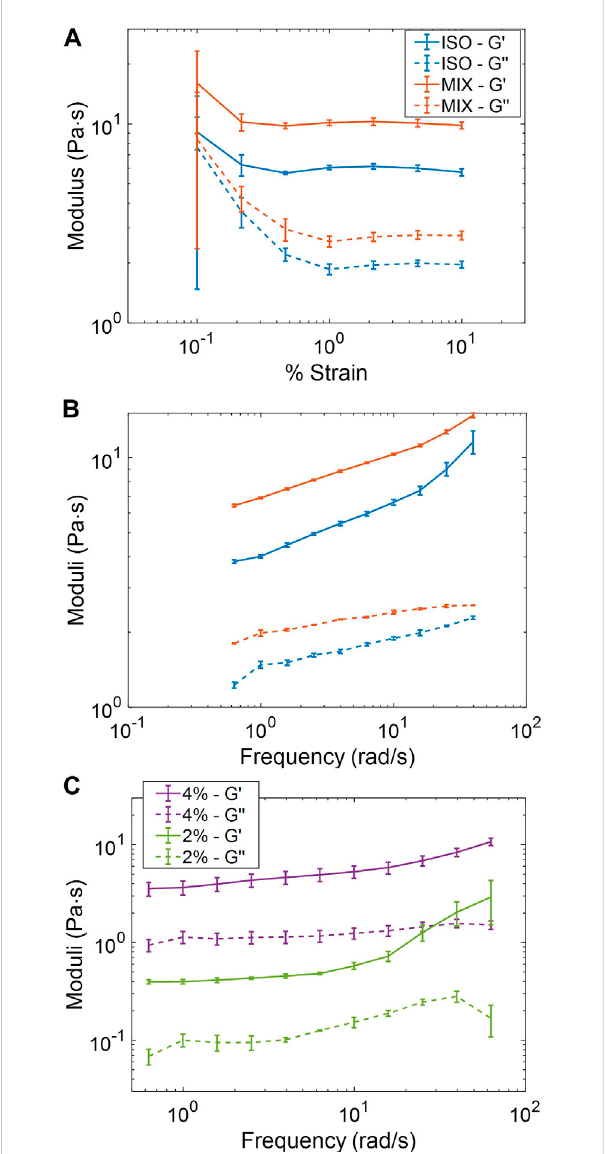
FIGURE 2 Macrorheological behavior of pooled ETT mucus samples. (A) ISO (5%) and MIX (5.6%) pools collected the same week demonstrated qualitatively similar behavior and an LVR at ≥ 1% strain. (B) ISO and Mix pools displayed qualitatively similar frequency responses with cleargel-likebehavior. (C) FrequencyresponseoftheADDpoolattwo